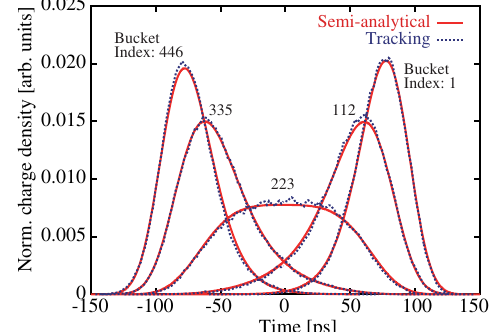
FIG. 6. Typical longitudinal distributions of particles that were predicted by the semianalytical calculation (red) and the tracking simulation (blue). Abscissa indicates the time delay ( ¼ ϕ = ω Assumed parameters are the same as in Fig.